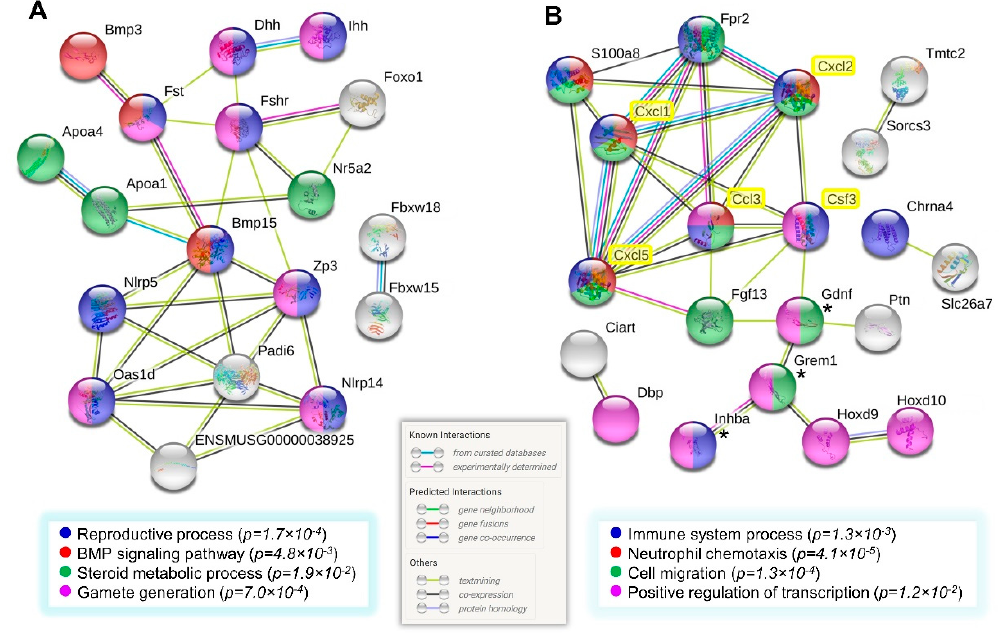
Figure 5. Protein–protein interaction network of genes associated with follicles and innate immunity in aged multiparous ovaries: The follicular-like ( A ) and the cytokine-like ( B ) gene clusters were analyzed with STRING v11 for known and predicted relationships existing as protein–protein interaction networks. The corresponding official Mus musculus gene symbols for the cytokines measured in serum were added to both the follicular (27) and the cytokine (32 and 6) clusters separately, to run each analysis. Serum cytokines are highlighted in yellow boxes in ( B ). The confidence score was set to 0.350, and the unconnected nodes were excluded from the network. Boxes at the bottom of each network indicate color codes for GO terms enriched in the respective protein networks (adj p < 0.05). (*) indicate genes that belong to the cytokine cluster, but show primary evidence of follicle function (see Tables 2 and 3). Legend to color-coded interaction lines were adapted from the STRINGv11 output.